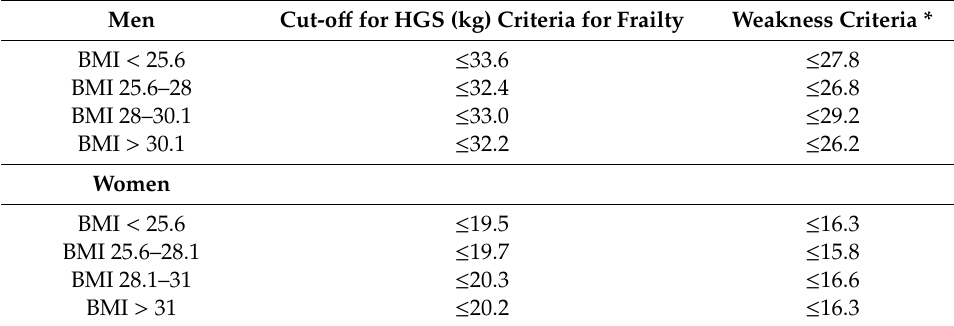
Table 4. Handgrip strength, stratified by gender and body mass index (BMI) quartiles. Men Cut-o ff for HGS (kg) Criteria for Frailty Weakness Criteria * BMI < 25.6 ≤ 33.6 ≤